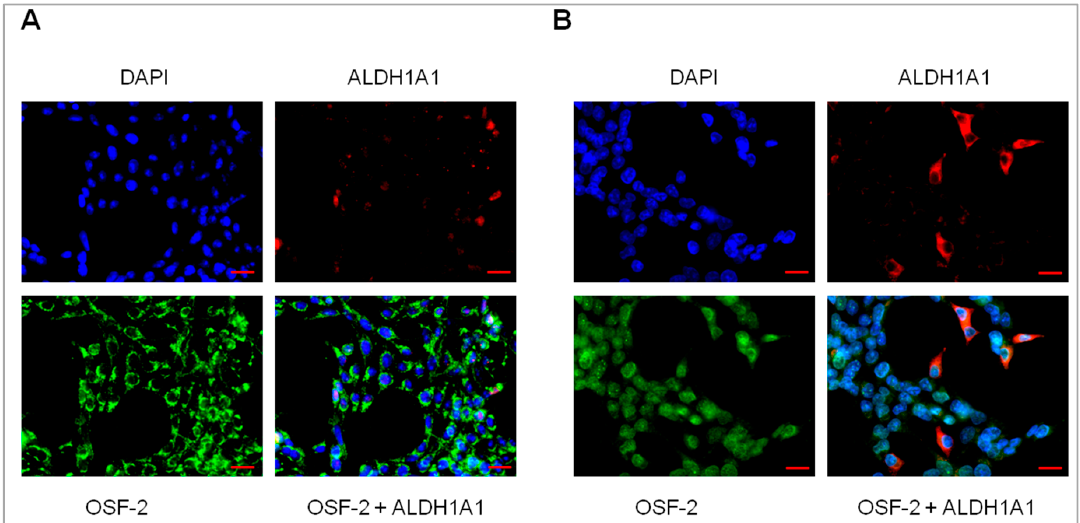
Figure 6. Immunofluorescence visualisation of ALDH1A1 and OSF-2 co-expression in ( A ) the W1DR cell line and ( B ) W1MR cell line. No simultaneous expression of OSF-2 and ALDH1A1 was revealed. ALDH1A1 was detected using the anti-ALDH1A1 antibody and Alexa Fluor ® 594-conjugated secondary antibody (red). OSF-2 was detected using the anti-OSF-2 antibody and Alexa Fluor ® 488-conjugated secondary antibody (green). To visualize the cell nuclei, the cells were mounted with a DAPI-containing mounting medium (blue). Objective x40. Scale bar = 20 µm.